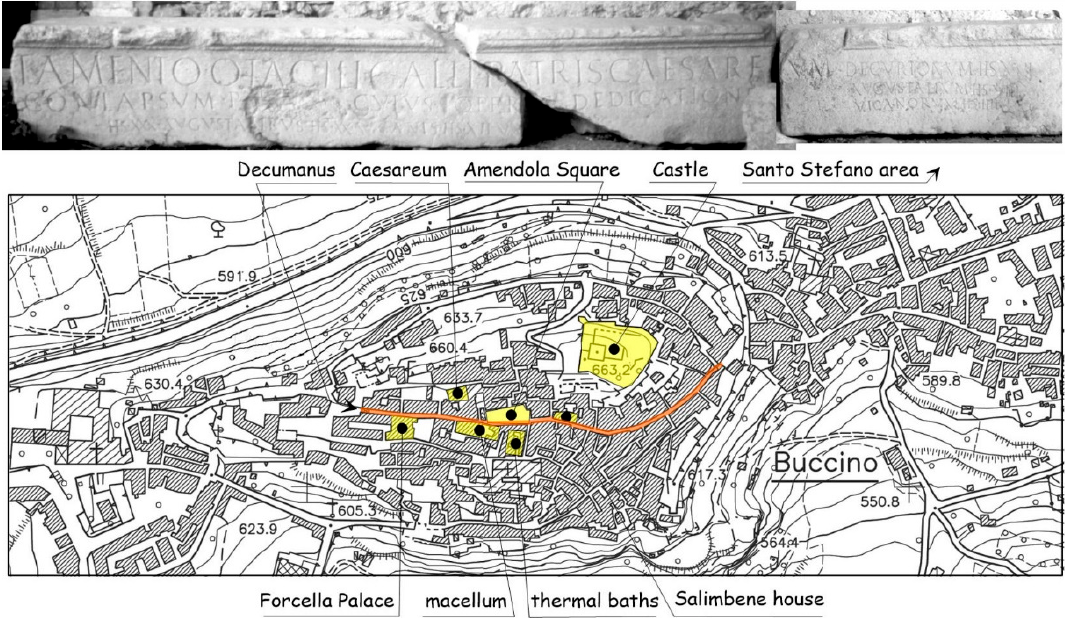
Figure 3. Map of Buccino showing the main archaeological sites attesting the 1st century CE earthquake. Upper panel is the photomosaic of the epigraph of Otacilius Gallus, a far ancestor of mine, attesting the collapse of the Caesareum (photo by P.G.).